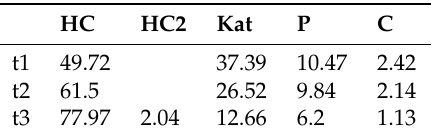
Table 2. Rietveld refinement of the time series of LDHs t1 = 1h, t2 = 3h and t3 = 6h. HC indicates the